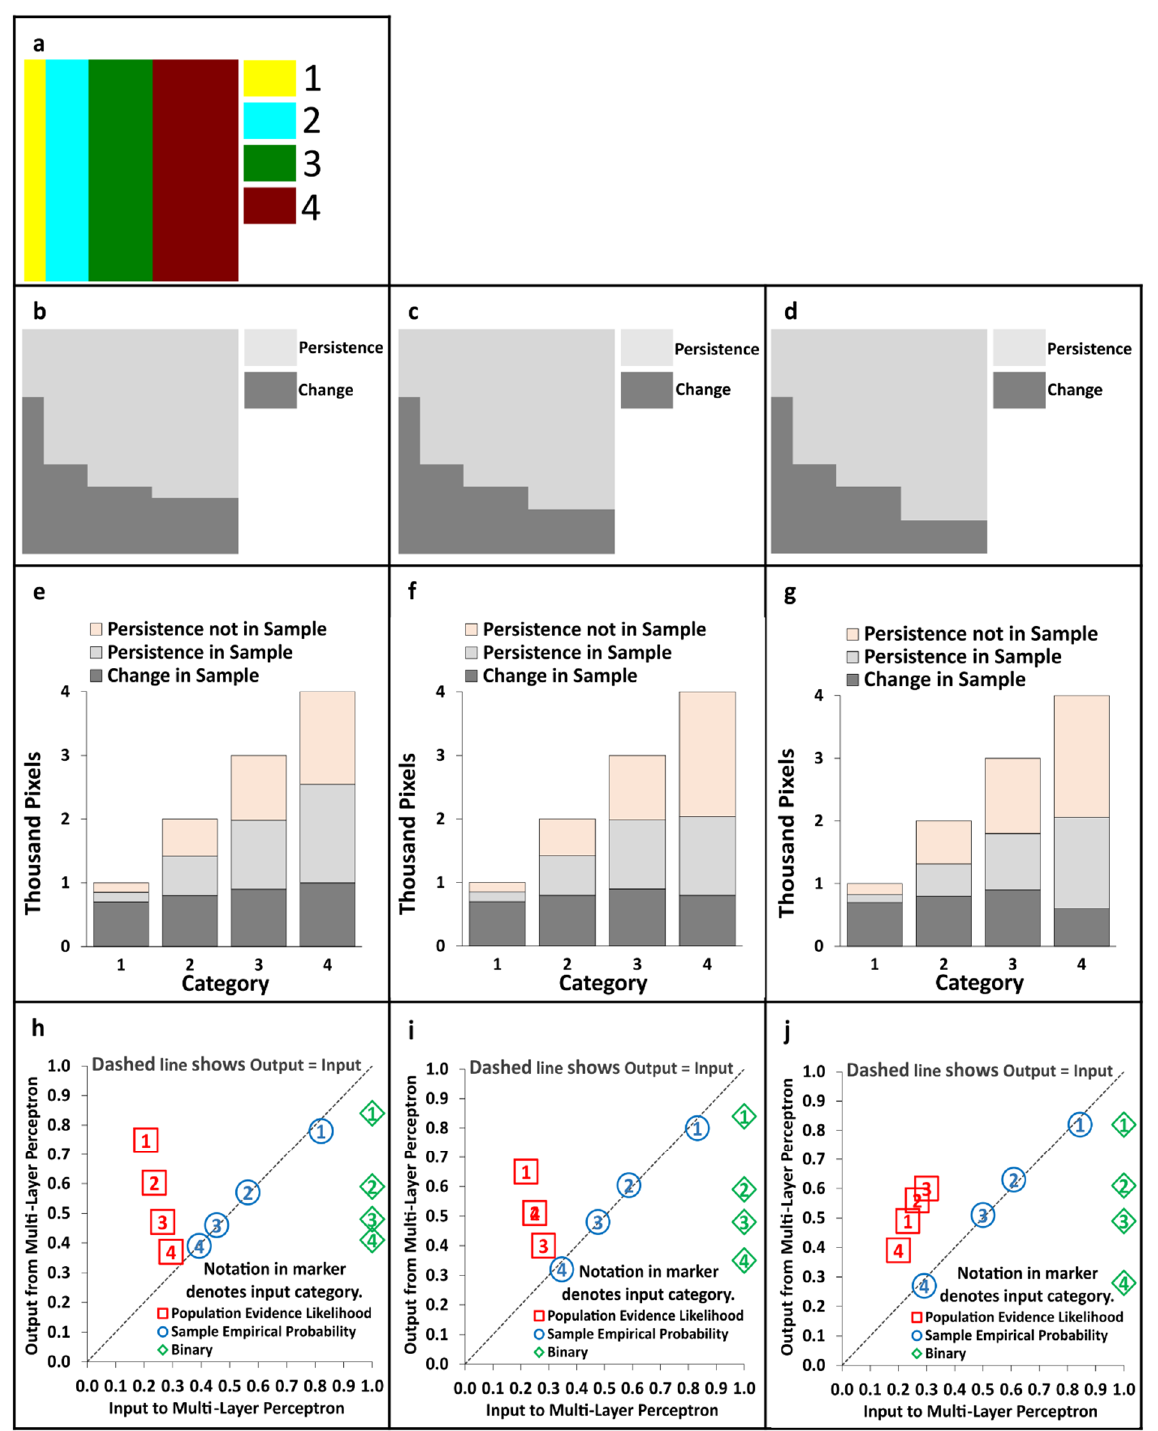
Figure 2. Designed data shows that Sample Empirical Probability is robust to smoothing, unlike Population Evidence Likelihood. ( a ) The independent categorical variable. ( b ) Case I dependent variable, where change intensity declines from categories 1 to 4. ( c ) Case II dependent variable, where the change intensity of category 4 shrinks from case I. ( d ) Case III dependent variable, where the change intensity of category 4 shrinks from case II. ( e ) Case I bars, where category 4 has the largest change size. ( f ) Case II bars, where category 4 has the same change size as category 2. ( g ) Case III bars where category 4 has the smallest change size. ( h ) Case I scatter plot, where the three encoding methods produce similar output. ( i ) Case II scatterplot, where PEL renders the MLP unable to distinguish between categories 2 and 4. ( j ) Case III scatter plot, where PEL produces a category ranking different from the other encoding methods.